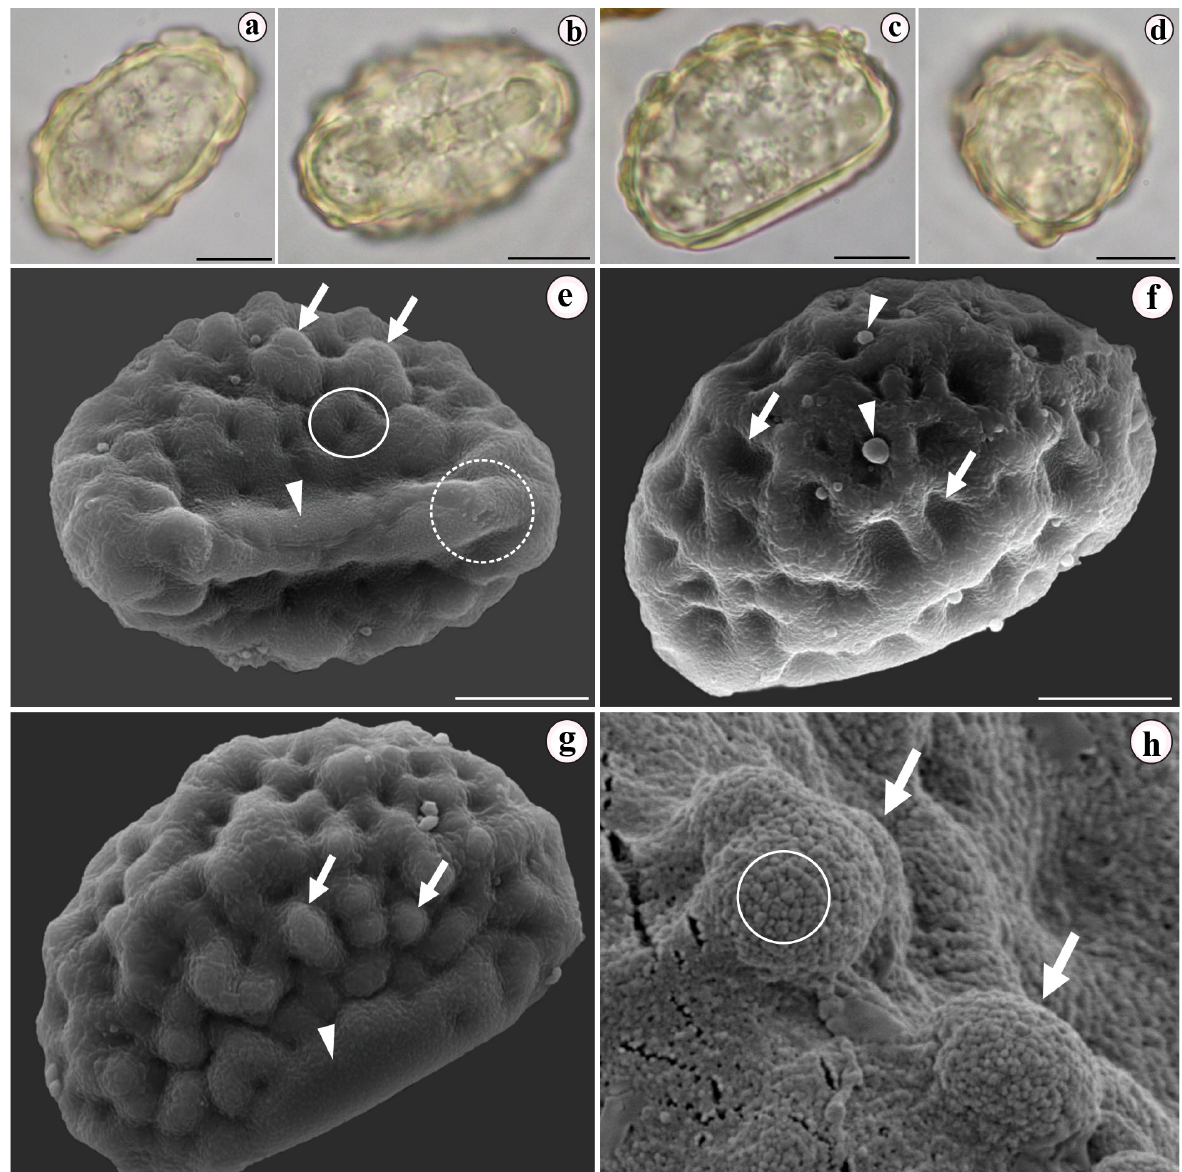
Figure 3 - Spores of Histiopteris incisa with LM and SEM. Tuberculate-reticulate sculpture. Figs. a-d. Mature spores with LM. a. Distal view. b. Proximal view. c. Major equatorial view. d. Minor equatorial view. Figs. e-h. Spores with SEM. e. Spore in proximal view. The sculpture is tuberculate-reticulate. The tubercles are spaced on the equatorial surface (arrows) and are fused forming reticules with small lumia (continue circle) in proximal view. Thickenins are observed at both sides of the laesurae (arrowhead), and can partially cover its ends (incomplete circle). f. Spore in distal view. The reticulum is conspicuous and has muri and lumina of variable sizes (arrows). Spheroid bodies can be seen on the surface (arrowhead). g. Spore in equatorial view. Tubercules partially fused are observed (arrows). The wall is thickened near of the lesurae (arrowhead). Specimen MP 4229. h. Detail of equatorial view. The surface of tubercles (arrows) is microverrucose (circle). Specimen MP 4218. Bars: a-g = 10 µm; h = 2